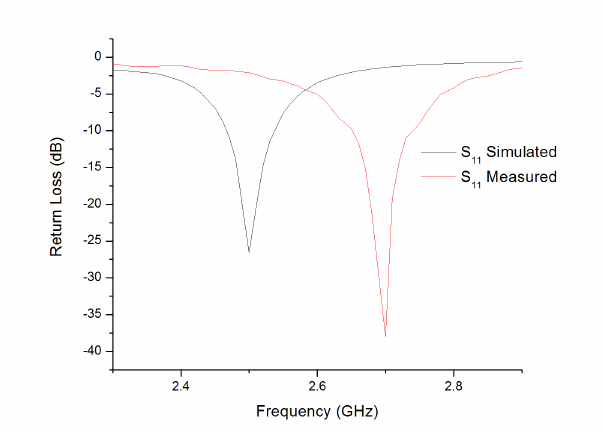
Figure 4: Simulated and measured return loss